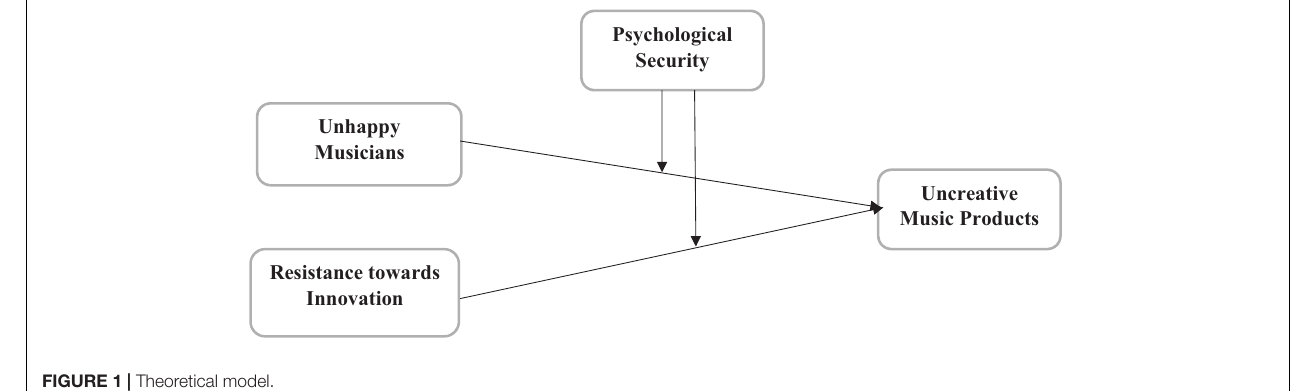
FIGURE 1 | Theoretical model.